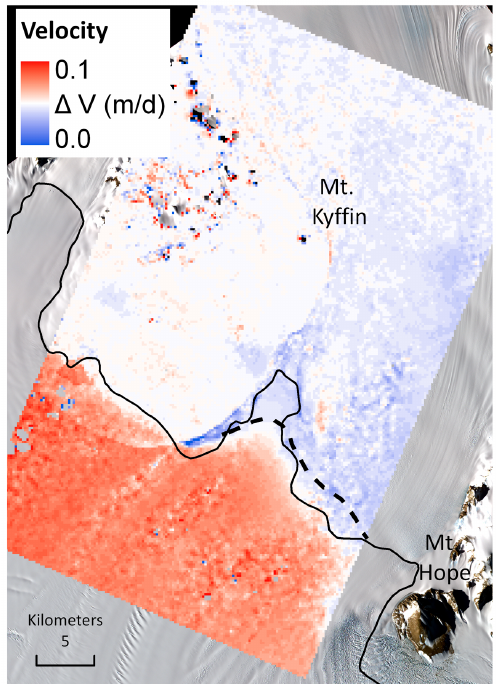
Fig. 6a. Difference in velocity in look direction between 1/2 De- cember and 1/2 June highlighting the influence of the tides down- stream of the grounding line.